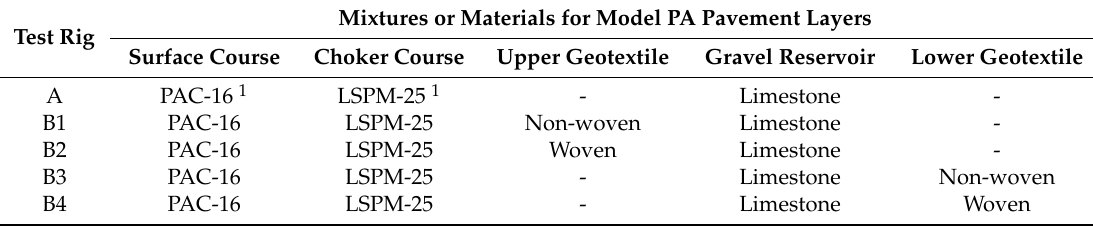
Table 1. Details of the porous asphalt (PA) system models paved in test rigs.